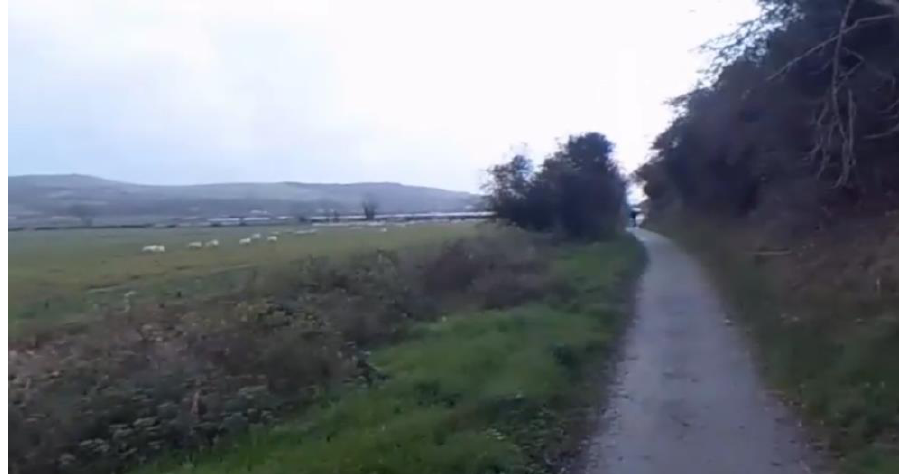
Figure 1. The 360° video experience image representation of video from user’s perspective. Figure 1. The 360 ◦ video experience image representation of video from user’s